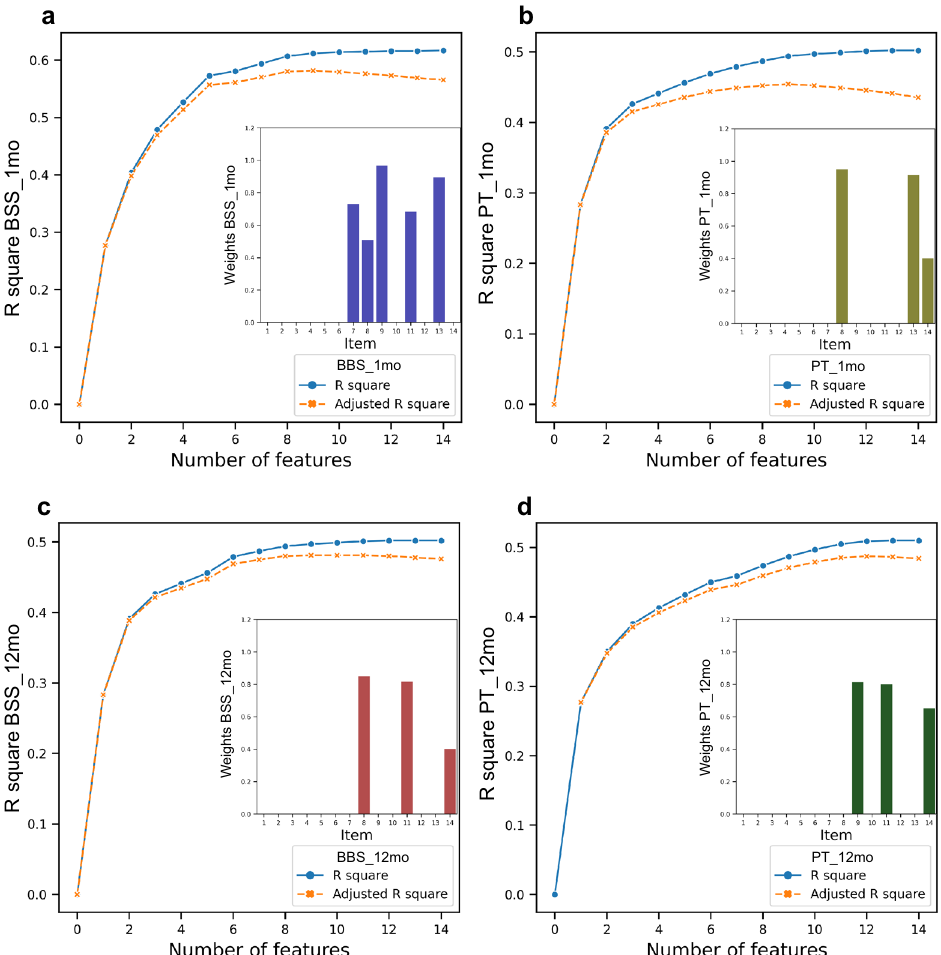
Fig. 4 Model selection by backward feature elimination in exploring the relative importance of subitems of BBS in off-medication conditions. Blue curves represented R-square. Orange curves represented the adjusted R-square. The relative weights of the signi fi cant features are shown on the bottom right of each plot. a Regression of data based on the dichotomy of BBS improvement in the M1. b Regression of data based on the dichotomy of BBS improvement in the M12. c Regression of data based on the dichotomy of PT improvement in the M1. d Regression of data based on the dichotomy of PT improvement in the M12. The subitems of BBS: item-1, sitting to standing; item-2, standing unsupported; item-3, sitting unsupported; item-4, standing to sitting; item-5, transfers; item-6, standing with eyes closed; item-7, standing with feet together; item-8, reaching forward with outstretched arm; item-9, retrieving object from fl oor; item-10, turning to look behind; item-11, turning 360°; item-12, placing alternate foot on stool; item-13, standing with one foot in front; and item-14, standing on one foot. BBS, Berg balance scale; PT, pull test; M1, 1-month follow-up; M12, 12-month